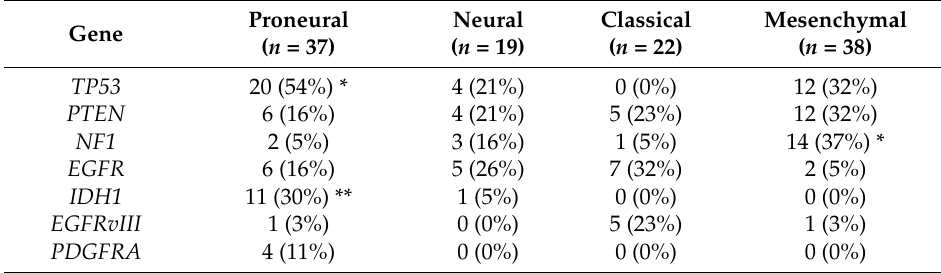
Table 1. Frequently-mutated genes in